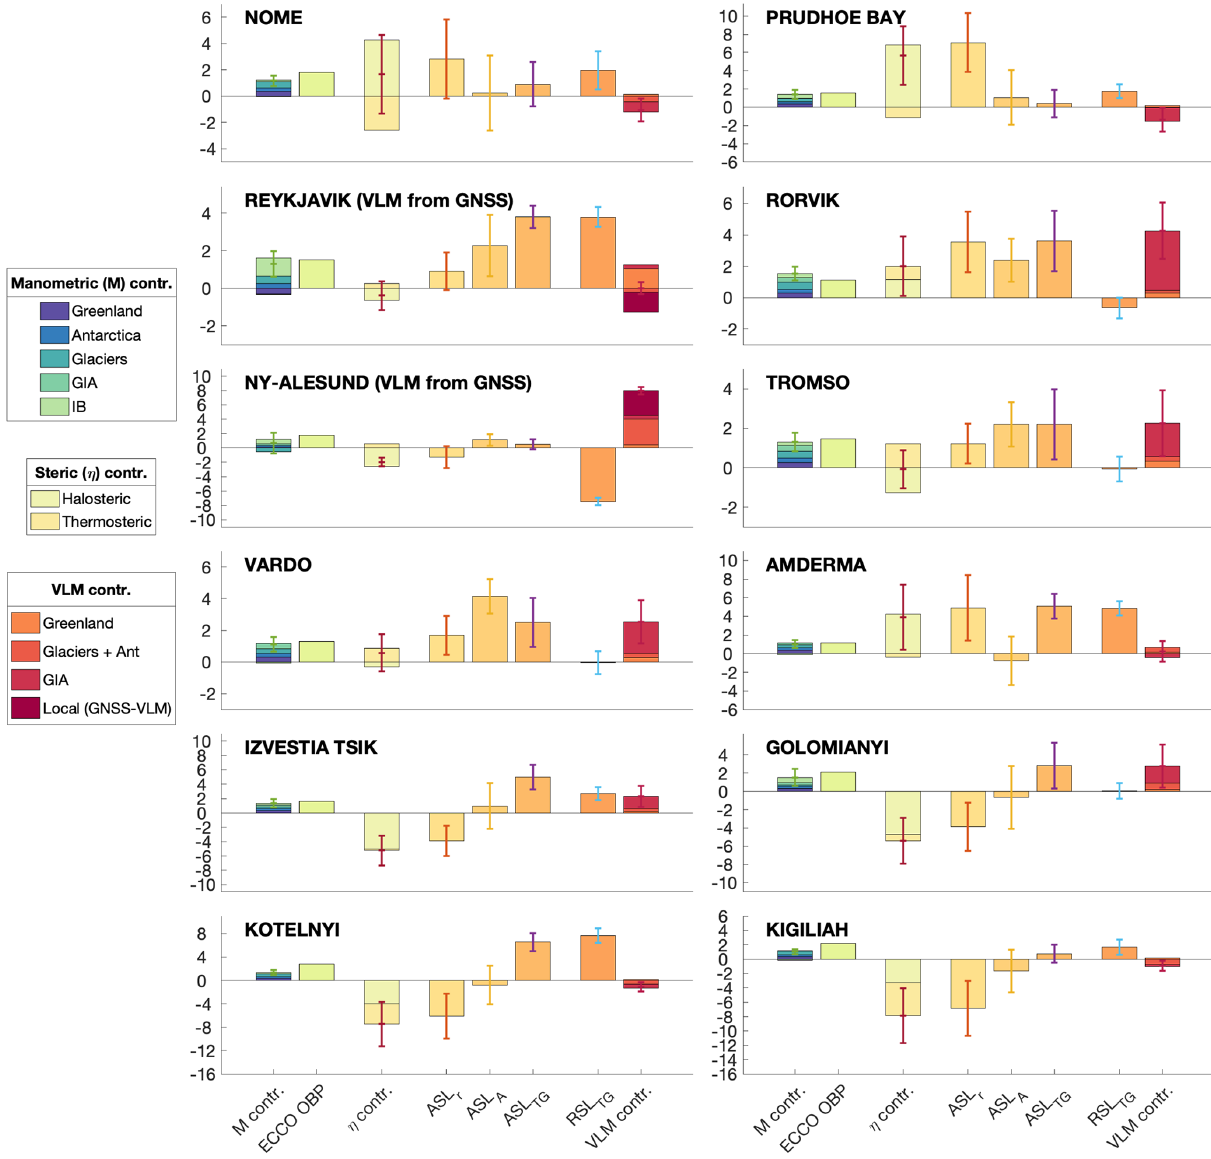
Figure 10. Components of sea level trend [mmyr − 1 ] for each tide gauge from 1995–2015. The three bars in the middle ( ˙ ASL r , ˙ ASL A and ˙ ASL TG ) are the three independent estimates of absolute sea level. The error bars indicate 1 standard error (combined error from each component when relevant) equivalent to the 68% confidence level. The VLM component “local (GNSS–VLM)” is only relevant at Reykjavik and Ny-Ålesund because significant local properties cause VLM that is not present in the VLM model (Ludwigsen et al., 2020b). The glacier component of VLM includes the effect of rotational feedback, ocean loading and Antarctica, which is less than 0.5mmyr − 1